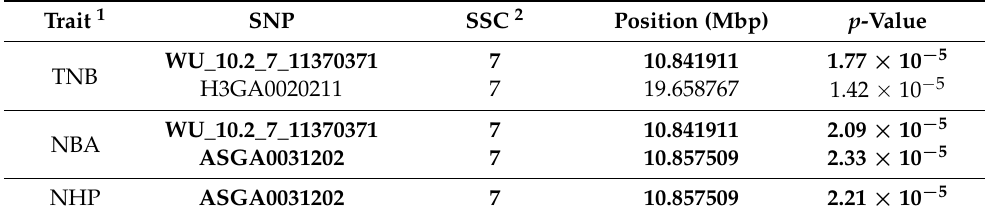
Table 3. Significant SNPs for litter traits.